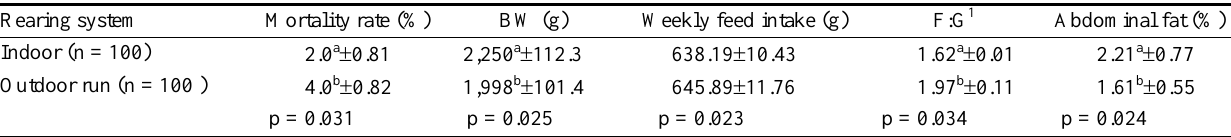
Table 3. Effect of rearing system on the performance of broiler Rearing system